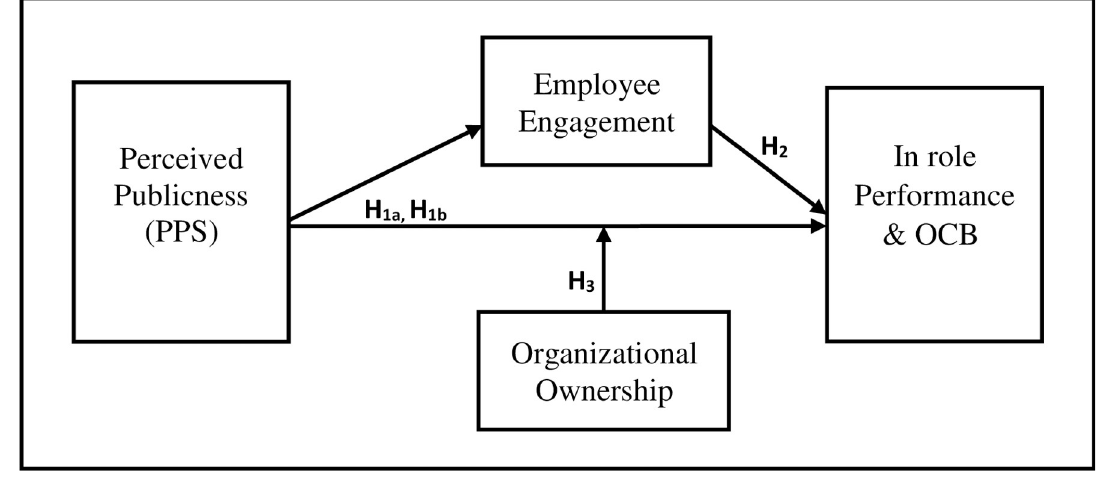
Fig 1. The research